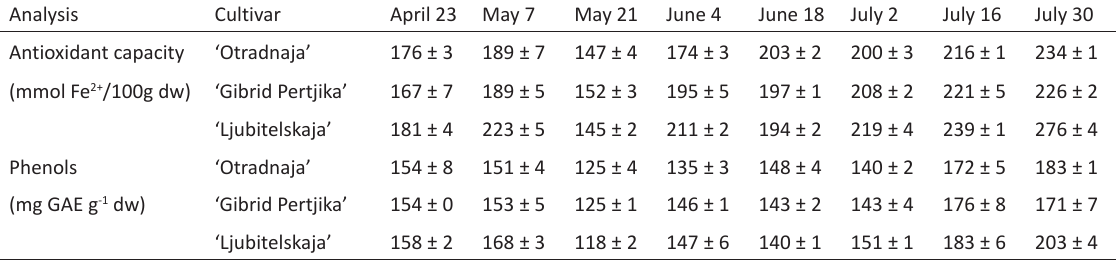
Table 1. Antioxidant capacity (FRAP analysis, n=2) and content of total phenols (Folin-Ciocalteu analysis, n=2) in sea buckthorn leaves for each sampling date and cultivar. For each analysis the average and standard deviation is presented (dw = dry weight, GAE = gallic acid equivalent).